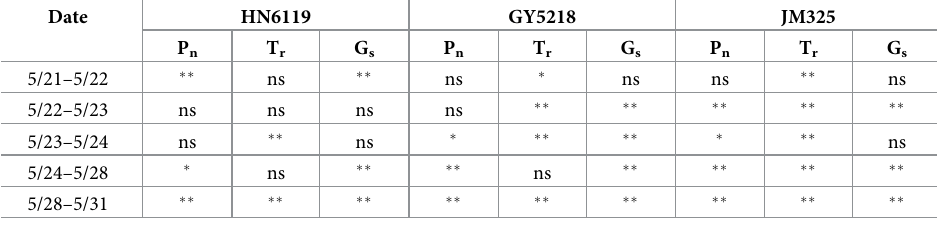
Table 3. Significance test of photosynthetic physiological parameters for the three cultivars during the 2019 experiment.